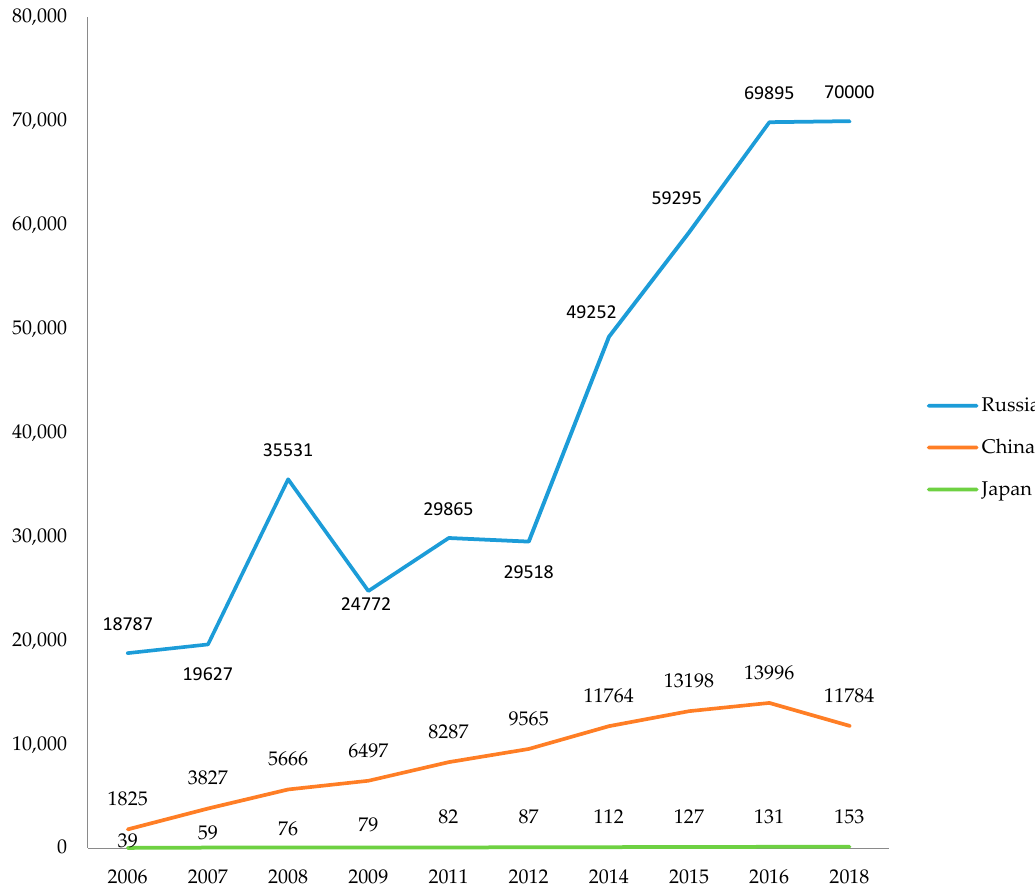
Figure 1. Outgoing mobility from Kazakhstan by destination country (both sexes), 2006–2018 Notes: * Based on data of UNESCO and the Ministry of Education and Science of the Russian Federation ** Based on data of the Ministry of Education of China and website China Education Online (China Education Online 2014).